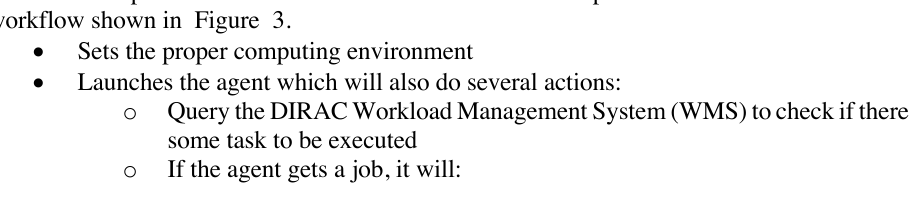
Figure 2. DIRAC Overview of the